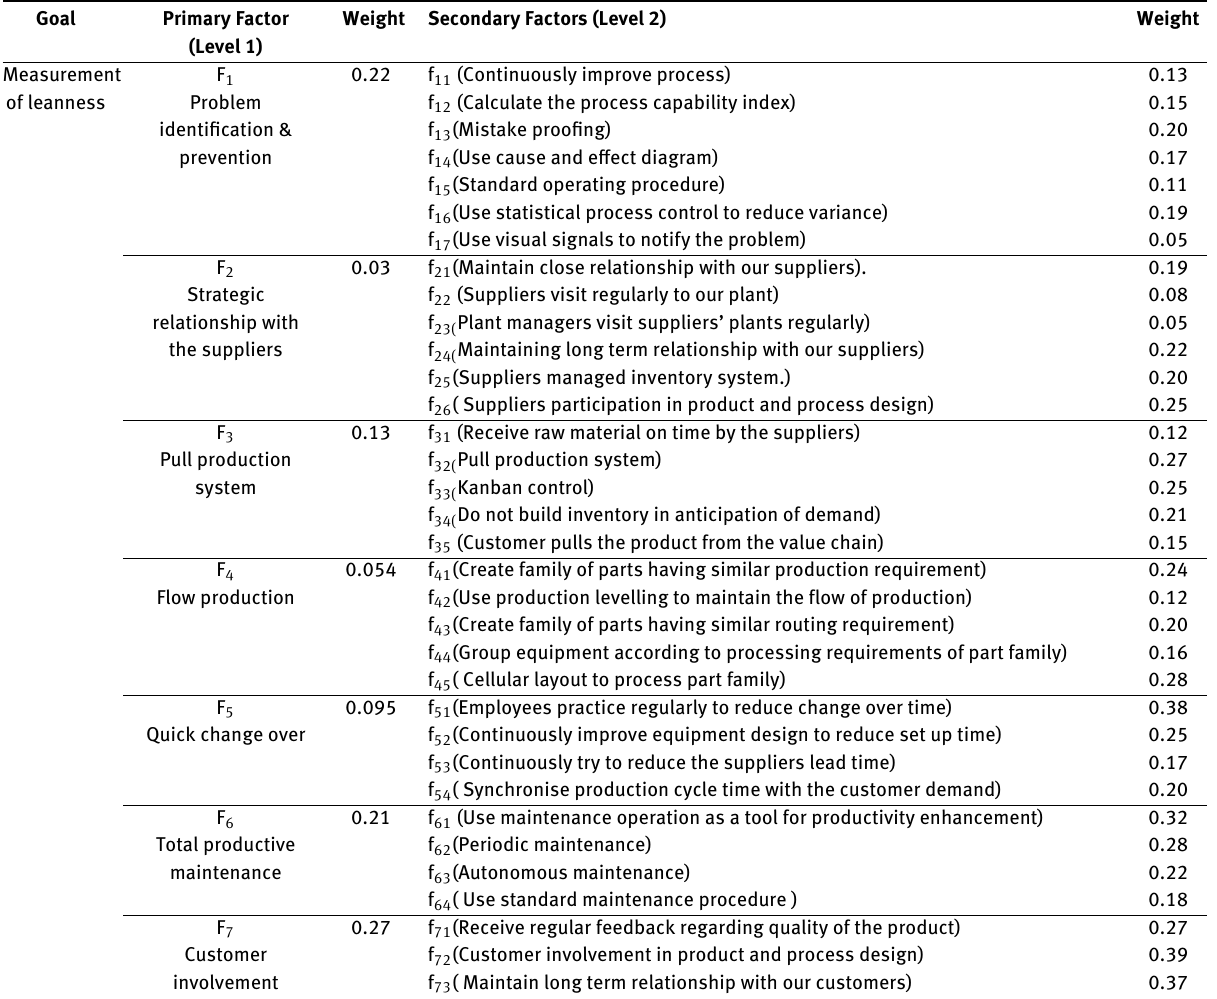
Table 6: Weight Indexing Goal